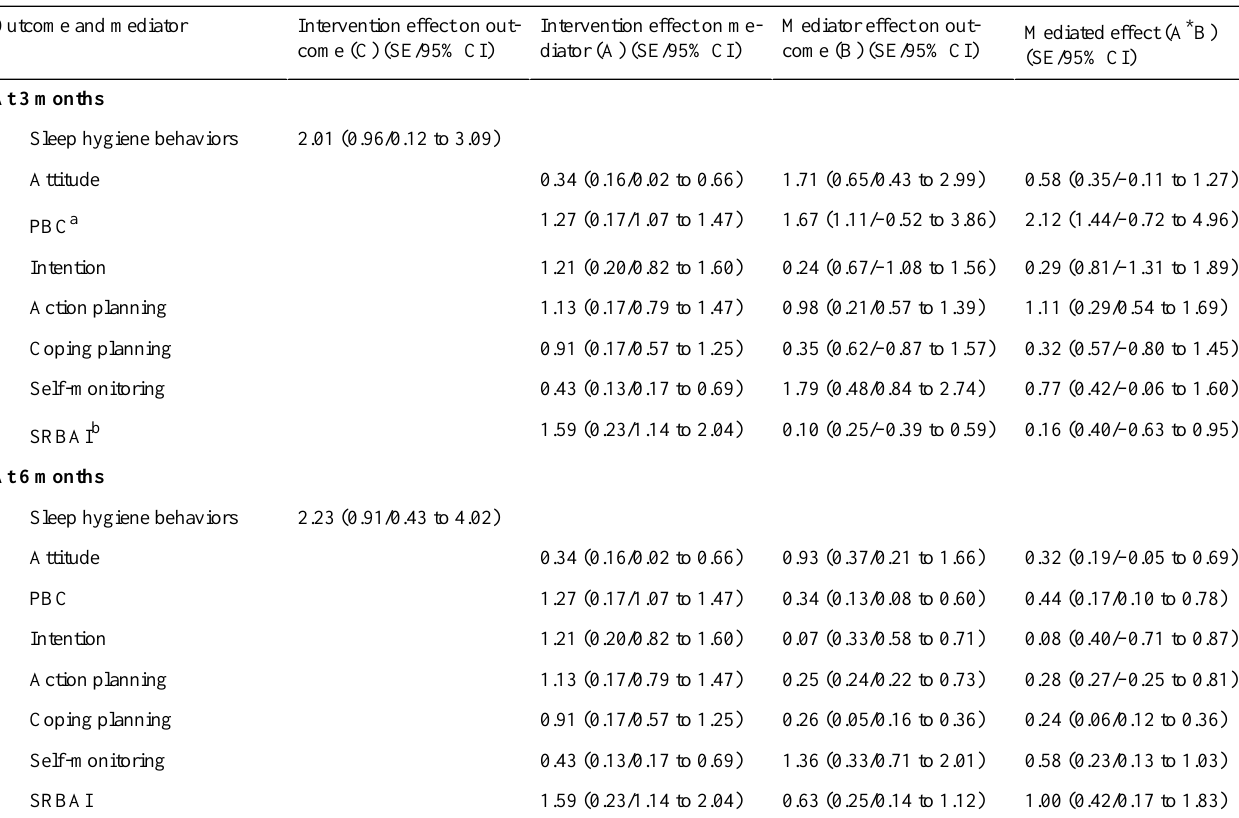
Table 7. Mediated effects of variables in theory of planned behavior, health action process approach, and control theory in the impacts of the